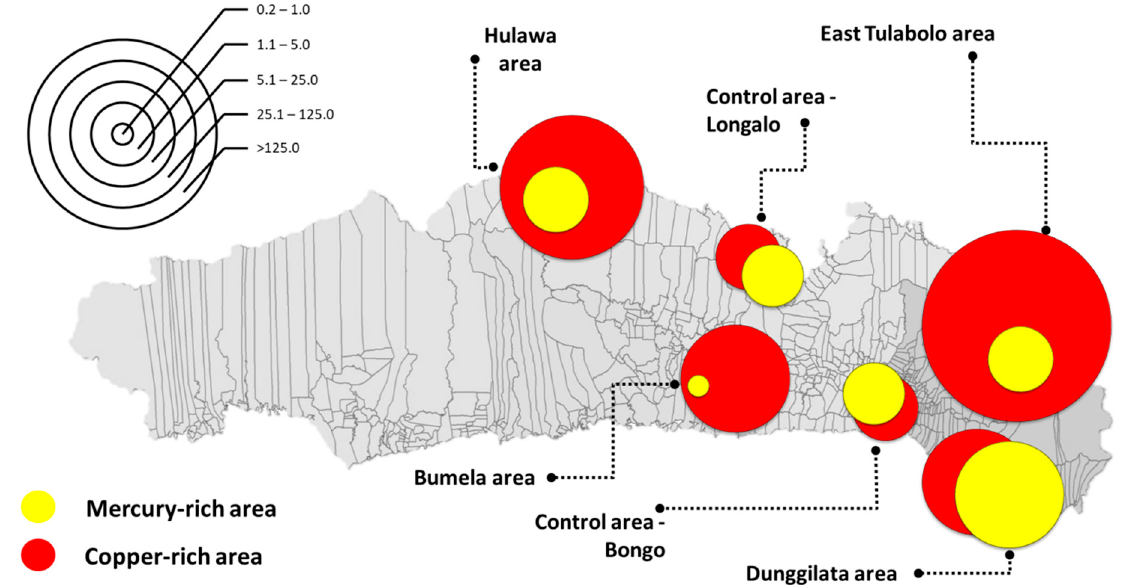
Figure 2. Mapping of copper (Cu) and mercury (Hg) hazard quotient per area. The scale in the left corner provides a parametric picture of the magnitude of the hazard quotient. The size of the circle is adjusted according to the hazard quotient ratio of each element, red for copper and yellow for mercury.